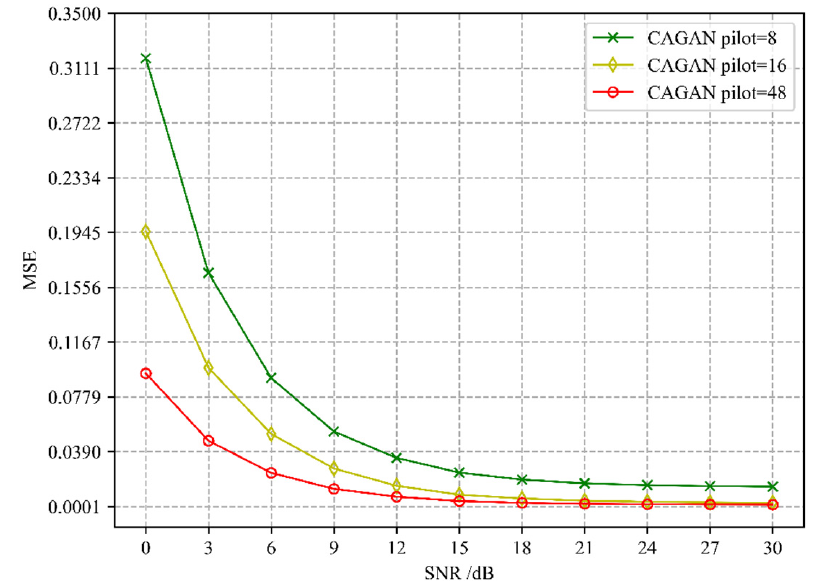
Figure 4. Comparison of CAGAN channel estimation accuracy with different pilot numbers.